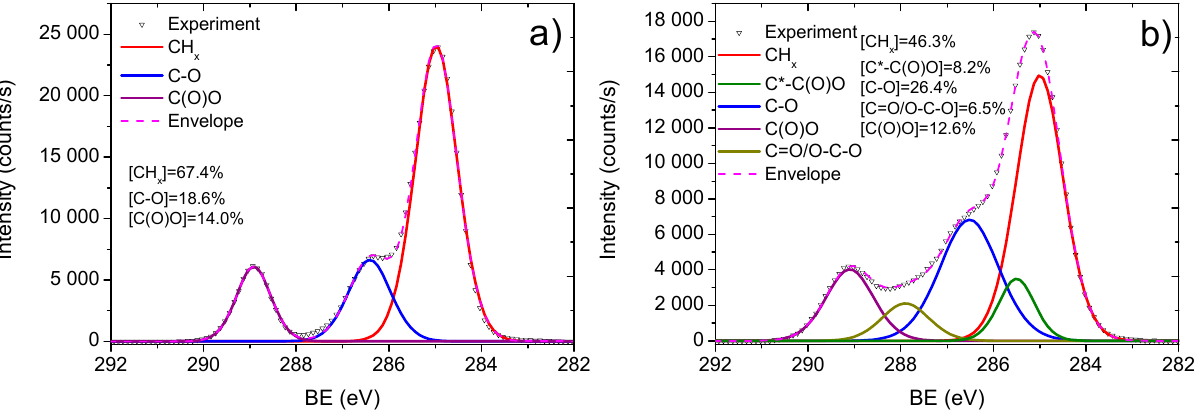
Figure 8. XPS C1s spectra of PCL-ref ( a ) and plasma polymerized Ar/CO 2 /C 2 H 4 layer deposited at CO 2 :C 2 H 4 ratio of 35:15 onto PCL nanofibers ( b ).